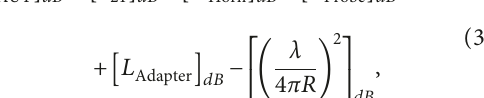
Figure 7: Simulated (blue) and measured (orange) radiation patterns in the XZ plane (a) and YZ plane (b) at the center frequency of 38GHz.